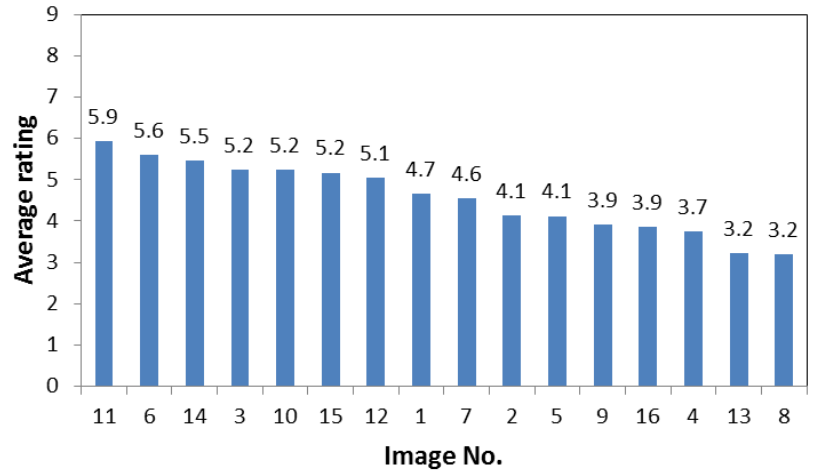
Figure 4. Average rating for question 5: preference for the structure shape in the picture. Water 2018 , 10 , x FOR PEER REVIEW